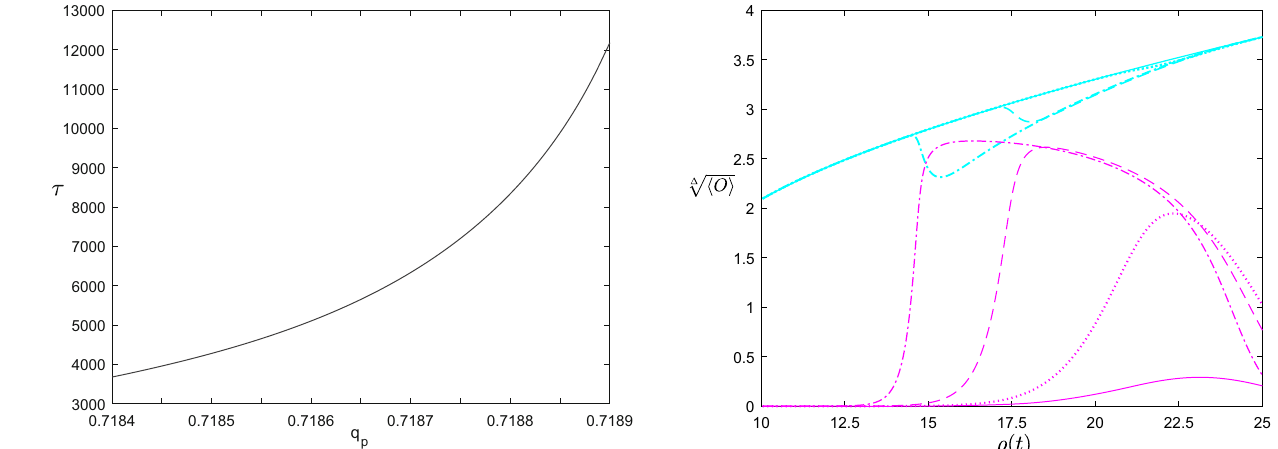
Fig. 6 The values of condensate for s-wave and p-wave orders in quenching processes with different quench rate v . The horizontal axis show both the time coordinate t and the value of ρ( t ) = t , while the ver- √ (cid:7) O (cid:8) . Cyan represents S-wave tical axis show the condensate values (cid:9) order while magenta represents p-wave order. q p is fixed to 0 . 7189. The dotted dashed lines, dashed lines and solid lines correspond to the processes with quench rates v = 0 . 00005, 0 . 0001, 0 . 00015 and 0 . 0002, respectively scale in this plot is different for the processes with different quench rate v